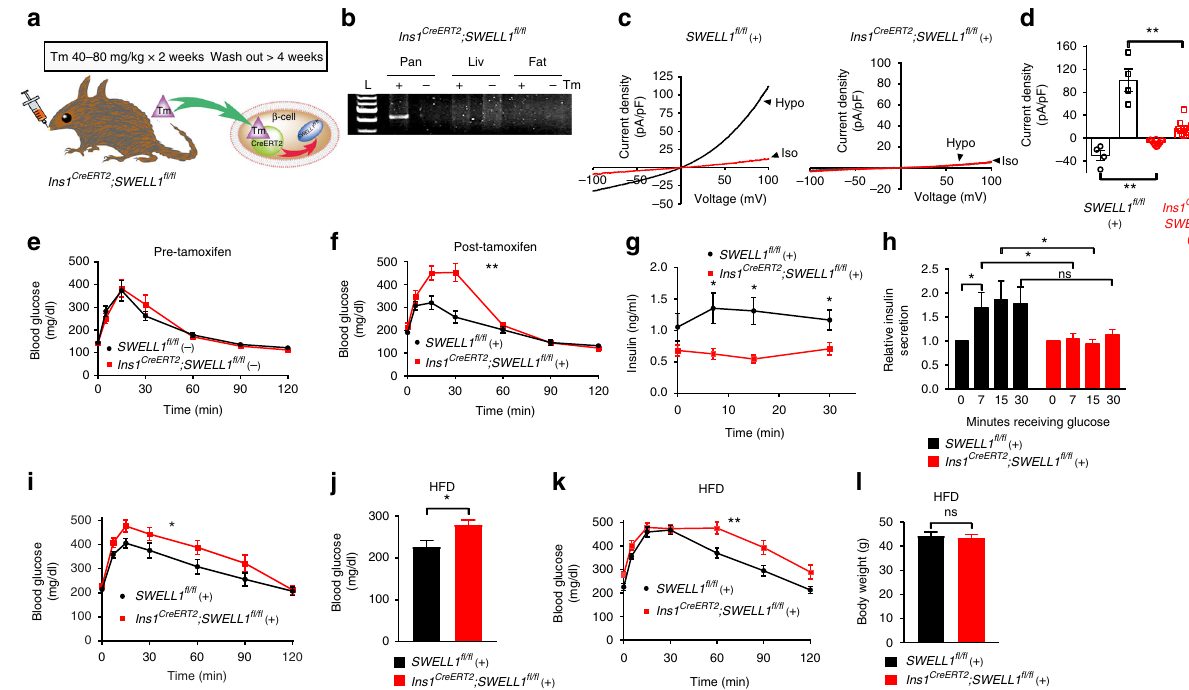
Fig. 8 Tamoxifen-inducible, β -cell-targeted Swell1 deletion impairs glucose-stimulated insulin secretion and systemic glycaemia. a Tamoxifen(Tm)- inducible β -cell-targeted Swell1 inactivation using Ins1 CreERT2 mouse crossed with Swell1 fl / fl mice ( Ins1 CreERT2 ; Swell1 fl / fl ). b PCR across S well1 Exon 3 in genomic DNA extracted from pancreas, liver, and adipose tissues of Ins1 CreERT2 ; Swell1 fl / fl mice treated with (+) or without ( − ) tamoxifen. Cre -mediated Swell1 recombination results in a 426 bp amplicon observed only in DNA extracted from the pancreas of Tm(+) treated Ins1 CreERT2 ; Swell1 fl / fl mice. c Current – voltage relationship of hypotonic swell-activated I Cl,SWELL in mouse primary β -cells isolated from Swell1 fl / fl treated with Tm (+, left) and Ins1 CreERT2 ; Swell1 fl / fl treated with Tm (+, right). d Mean inward and outward current densities at +100 and − 100 mV from Tm-treated S well1 fl / fl (+; n = 4 cells) and Ins1 CreERT2 ; Swell1 fl / fl (+; n = 10 cells) mice. e , f Glucose tolerance tests (GTT) (2 g/kg glucose i.p.) in Ins1 CreERT2 ; Swell1 fl / fl mice pre ( e , − ) and post ( f , +) Tm treatment, respectively ( Swell1 fl / fl , n = 7 mice; Ins1 CreERT2 ; Swell1 fl / fl , n = 6 mice) raised on a regular-chow diet. g , h Glucose-stimulated insulin secretion in Tm-treated Swell1 fl / fl (+) and Ins1 CreERT2 ; Swell1 fl / fl (+) mice in response to 2 g/kg glucose in the fi rst 30 min ( Swell1 fl / fl , n = 20 mice; Ins1 CreERT2 ; Swell1 fl / fl , n = 22 mice). i GTT (2 g/kg glucose i.p.) from Swell1 fl / fl (+) and Ins1 CreERT2 ; Swell1 fl / fl (+) mice ( n = 15, in each group) on a regular-chow diet. j Fasting serum blood glucose, k GTT (1 g/kg i.p.) and l body mass of the same cohort of mice in i after 5 – 6 weeks on HFD (60% fat, n = 15, in each group). Data are shown as mean ± s.e.m. In d , g , j , l , unpaired t -test are performed. In h , one-way ANOVA for in-group comparison, unpaired t -test for between-group comparison. In e , f , i , k , two-way ANOVA are performed. * p < 0.05; ** p < 0.01; *** p < 0.001. ns, not signi fi coated (Millipore, USA) glass cover slips and used for experiments after 24 – 48h at agitation, washed in RPMI containing 1% FBS and puri fi ed on Histopaque 1077 30 – 40% con fl uency. and 1119 gradients. Islets were then transferred to 60 mm Petri dish with culture medium for short-term culture ( < 24h). For GSIS experiments, islets were sorted for equal size and cultured in 24-well plates. For isolation of primary β -cells, CRISPR/Cas9-mediated Swell1 knockout in MIN6 cells . A CRISPR/Cas9-based isolated islets were further incubated in trypsin for 5min, dispersed into single tool was utilized to knockout Swell1 gene in MIN6 cells, where the target guide cells, and then transferred to matrigel-coated cover slips for patch clamp and sequences designed using web-based CRISPR design tool (http://crispr.mit.edu/) calcium fl uorescence imaging. were cloned into a bicistronic vector-expressing cas9 (pSpCas9(BB)-2A-Puro) 62 . Either 1A/2B (KO1) or 2B/3C (KO2) plasmids in combination were transfected into MIN6 cells using LipofectAMINE 2000 as per the manufacturer ’ s instructions (Supplementary Table 1). After a 48 h period, selection medium containing pur- omycin (1 µ g/ml) was added to the cells and maintained for 5 days. Individual clones from the enriched pool were further isolated by dilution method 62 . Swell1 gene deletion was con fi rmed by PCR ampli fi cation spanning the double guide targeted region (Supplementary Fig. 3), followed by SWELL1 western blot (Fig. 4a and Supplementary Fig. 6b). Human islets . Human islets were obtained through the Integrated Islet Distribu- tion Program (IIDP, shared with Dr John Engelhardt) or Prodo Laboratories (shared with Dr Yumi Imai). Ethical approval was not required for the in vitro studies using human islets obtained from IIDP and Prodo Laboratories. Patients were anonymous to the research team except for information of gender, age, and BMI. Islets were cultured in RPMI 1640 (2% FBS) and transferred to the laboratory within 24 h. Murine islet isolation . Swell1 fl / fl mice (8 – 14 weeks old) were killed by Avertin (0.0125g/ml, dissolved in H 2 O) injection (20 µ l/g, i.p.) followed by cervical dis- location according to the approved procedures. The pancreas was perfused via the common bile duct with 2 – 3ml HBSS containing type V collagenase (0.8 mg/ml), and then removed and digested at 37°C for 10 min. Islets were freed by gentle